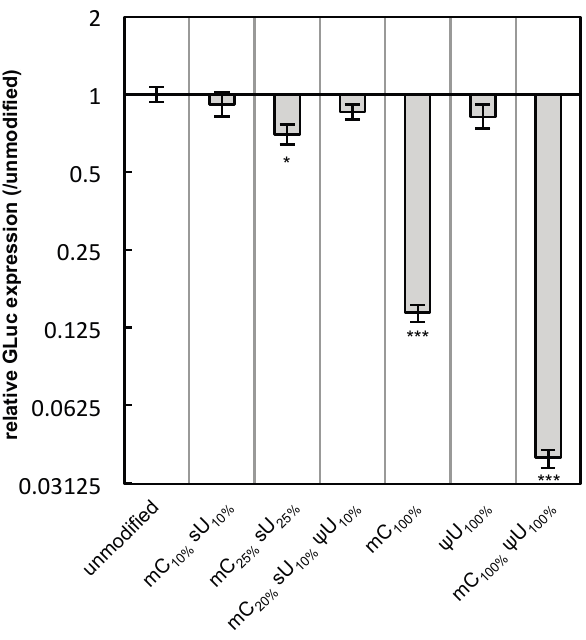
Figure 6. Translation efficiency of modified mRNA. mRNA-encoding GLuc in a naked form was incubated in a cell-free translation system composed of rabbit reticulocyte lysate. After 90 min, GLuc was measured. The graph shows relative values compared to